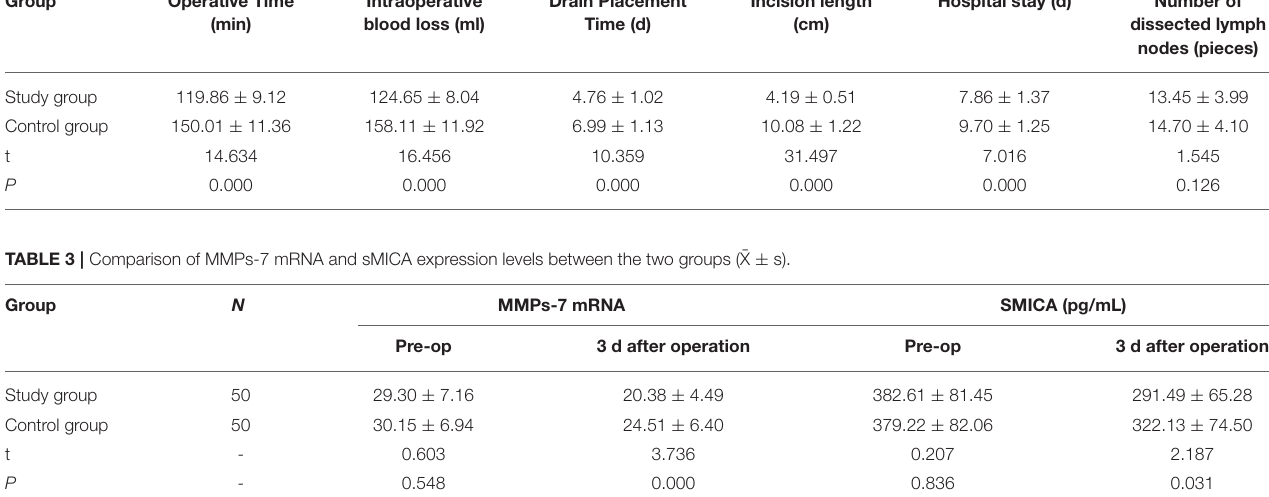
TABLE 2 | Comparison of perioperative indexes between the two groups (X ± s, n = 50). Group